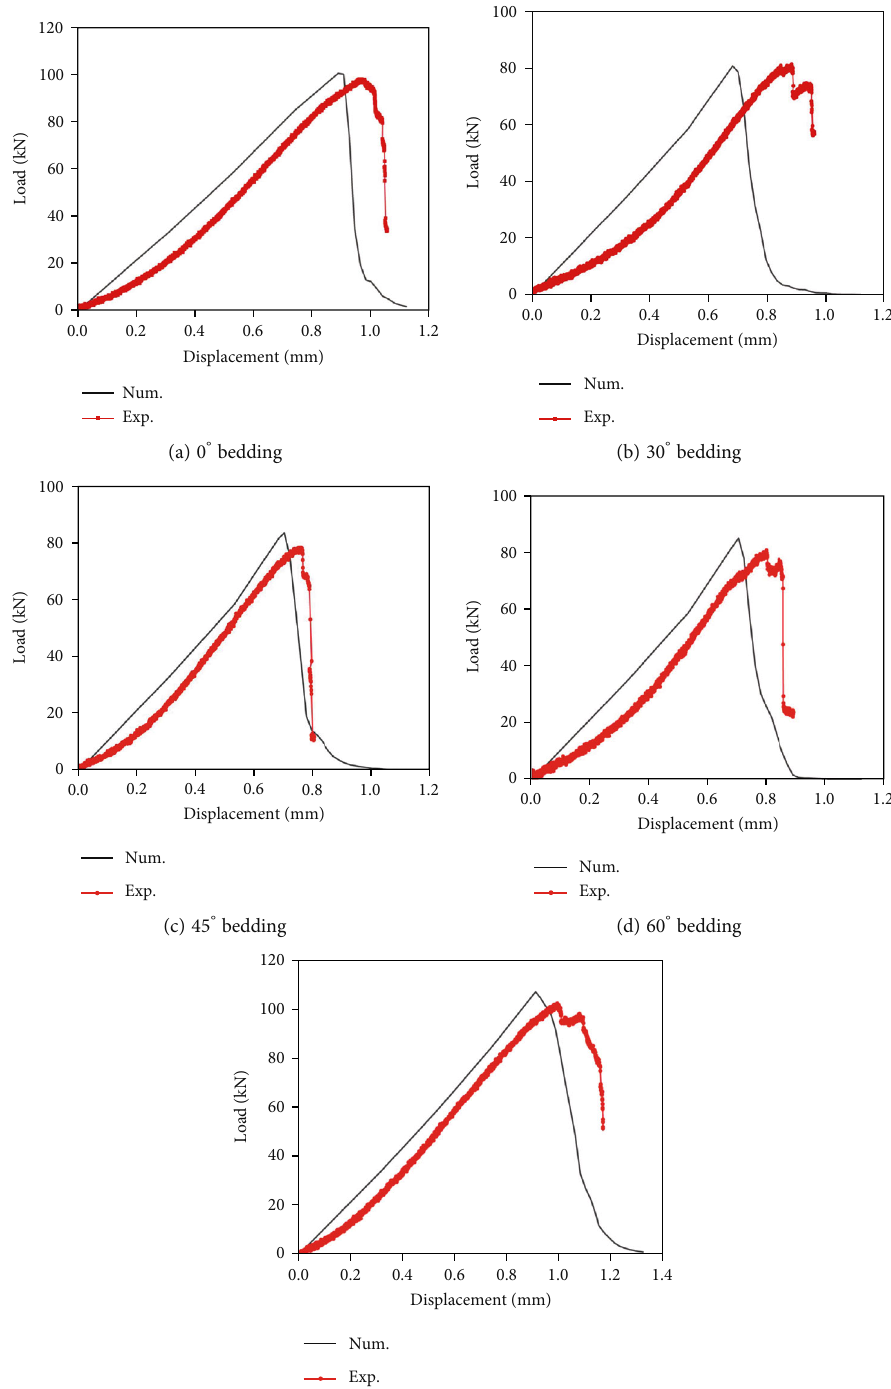
Figure 10: Schematic diagram of the comparison of load-displacement curves between test and simulation under di ff erent bedding inclination